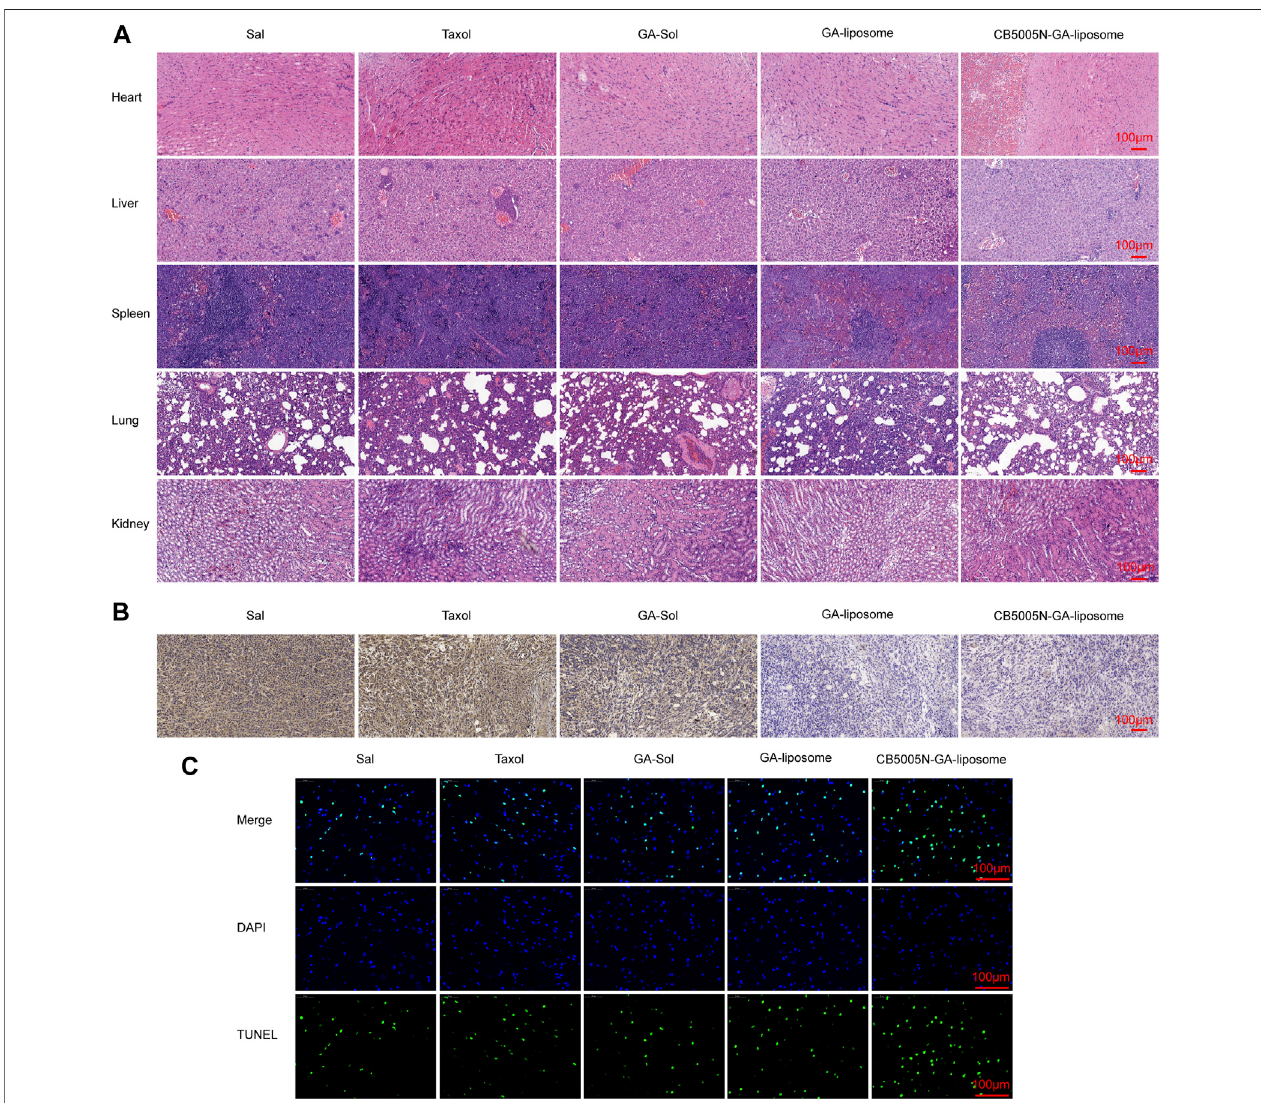
FIGURE 7 | (A) H&E staining of major organs (B) After different treatments, tumor sections were stained with CD31 and (C) TUNEL, Scale bar = 100 μ m. ( n = 4).